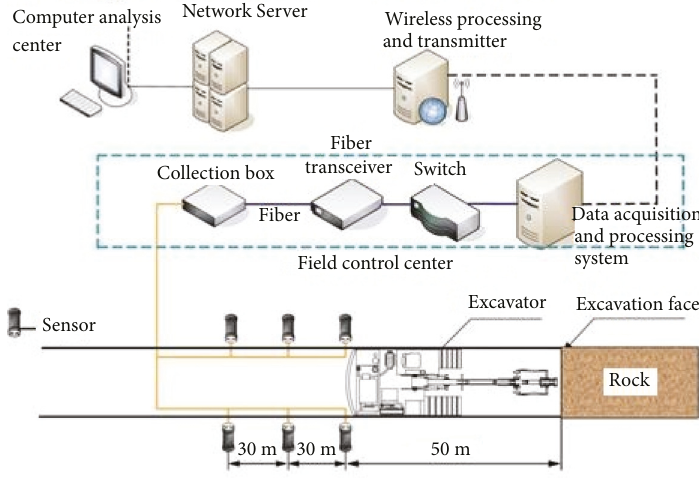
Figure 3: Layout of tunnel sensors.